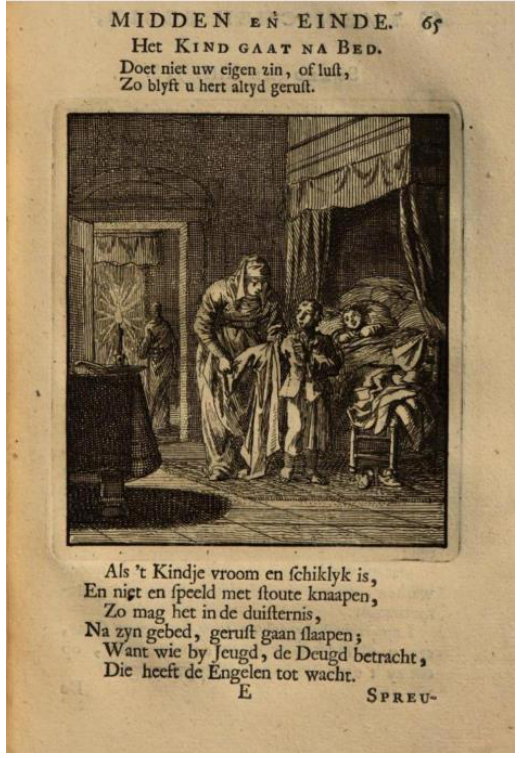
Figure 13. Jan Luyken, “ Het Kind Gaat Na Bed .”.